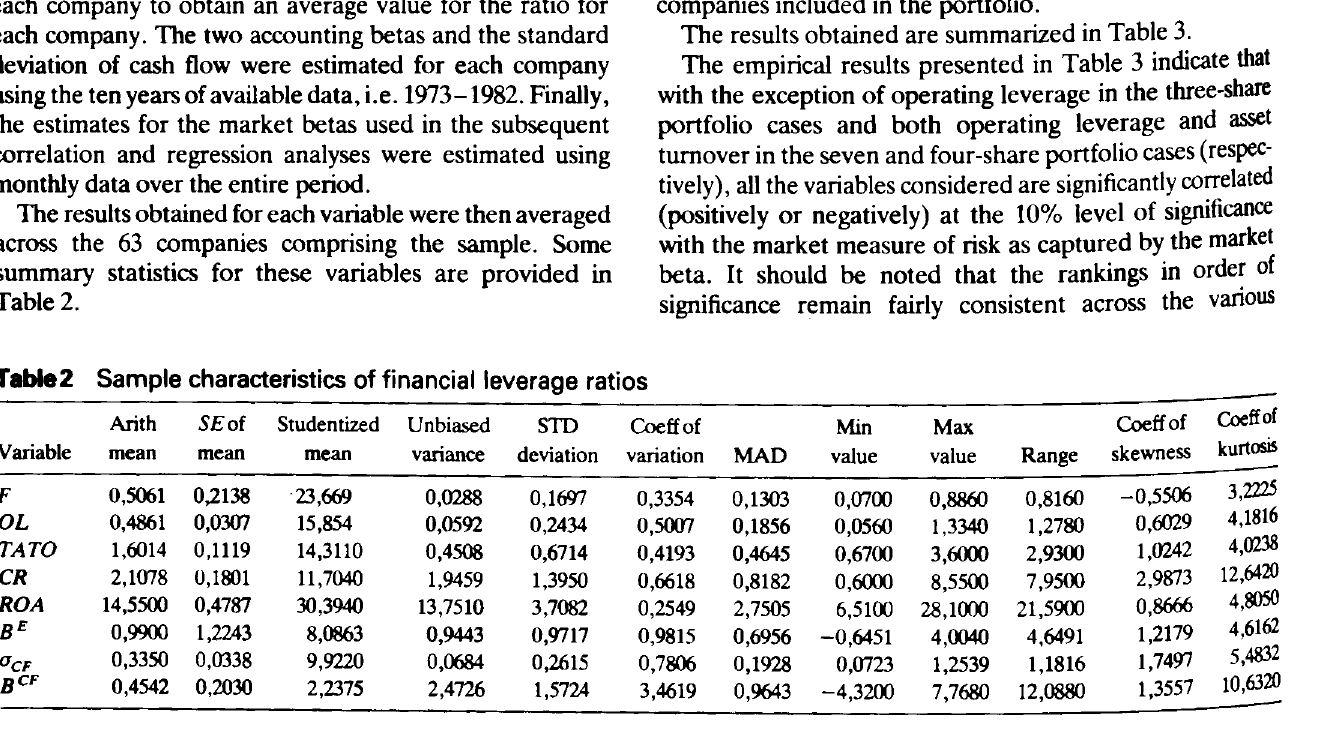
Table2 Sample characteristics of financial leverage